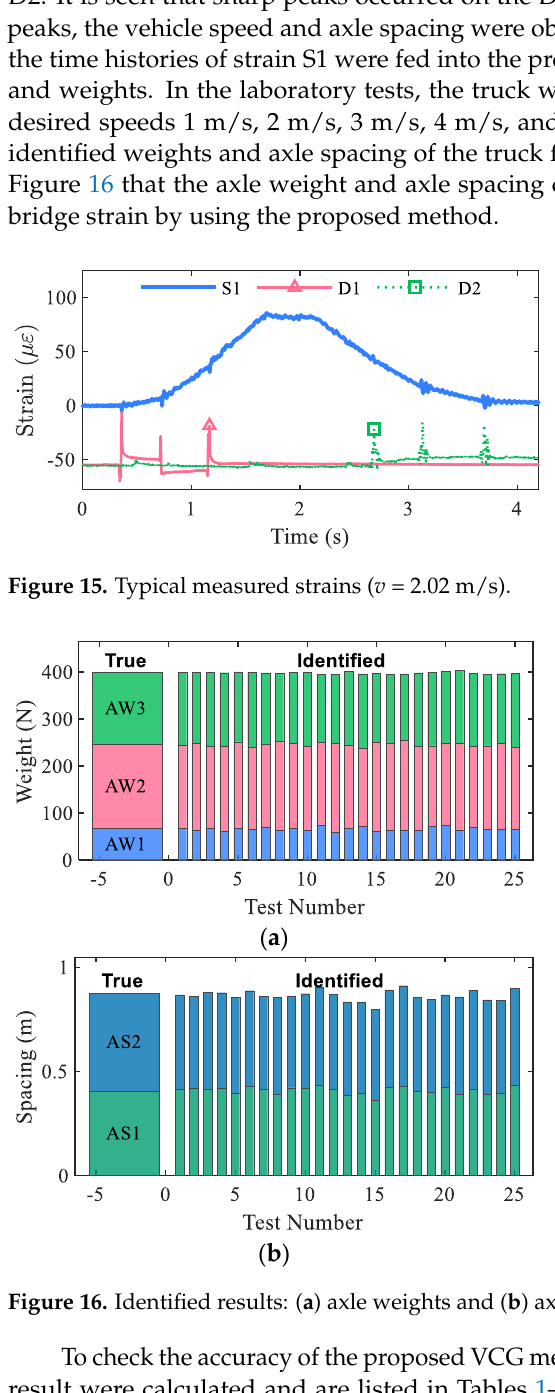
Figure 14. Bridge section and loading position.